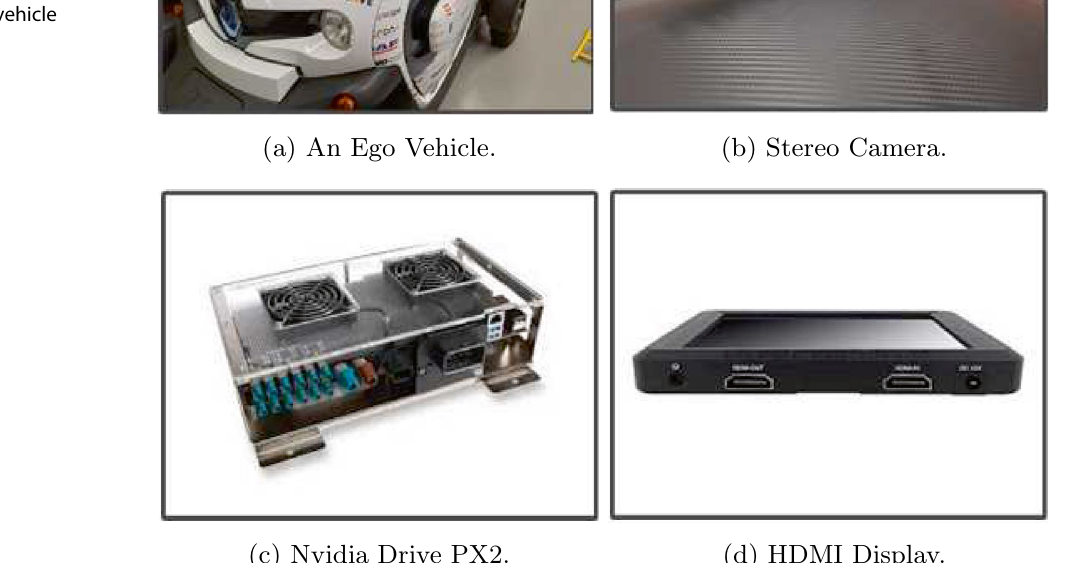
Fig. 12 A Twizy cooperative automated vehicle research platform: a An Ego vehicle equipped with b GMSL Stereo Camera (on the car roof using a rigid mounting bar), c Nvidia Drive PX2 (on the car roof using a rigid mounting box), and d HDMI Computer Monitor (at the back side of vehicle front seat)